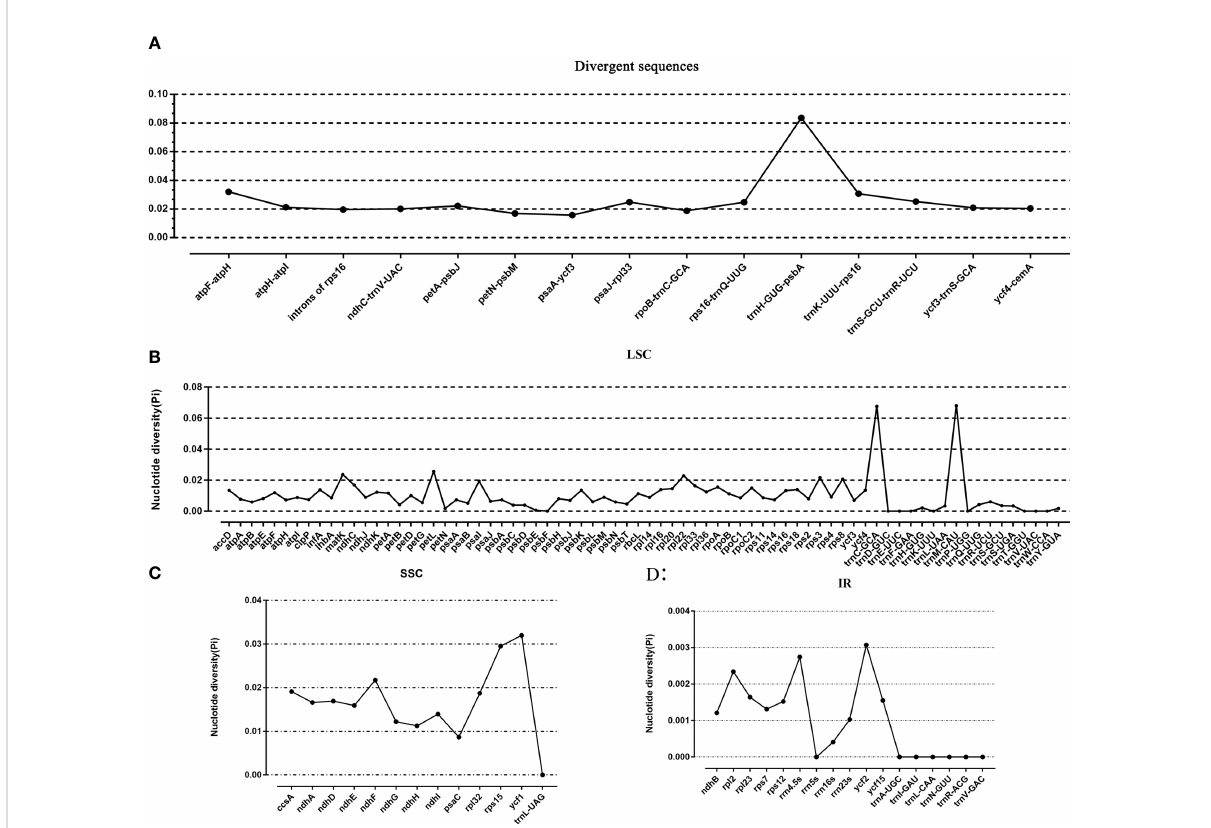
FIGURE 5 The nucleotide variability (Pi) value in the 12 Paraboea chloroplast genomes. (A) The Pi value of divergent sequences. (B) The Pi value of LSC region. (C) The Pi value of SSC region. (D) The Pi value of IR region.